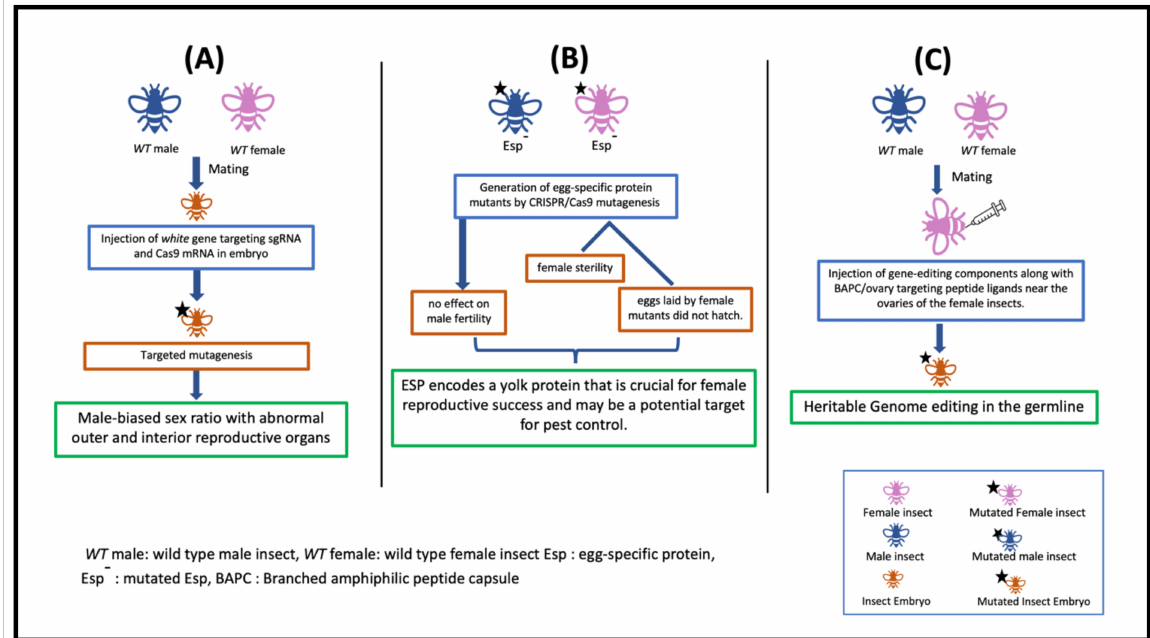
Figure 2. Figure shows three different CRISPR-based genome-editing approaches for insect pests management. ( A ) pictorial representation of sterile insect technique (SIT); ( B ) targeting female reproductive fitness through CRISPR/Cas9; ( C ) injection of CRISPR/Cas9 components with ovary targeting signals for producing heritable genome editing in the